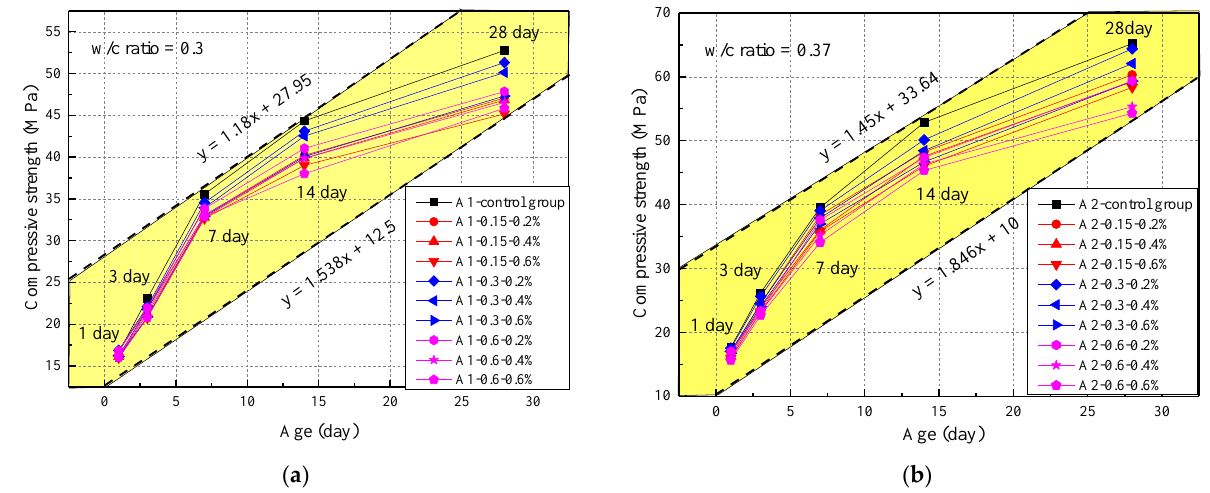
Figure 3. Concrete compressive strength under different water–cement ratios: ( a ) water–cement ratio of 0.3; ( b ) water– cement ratio of 0.37.